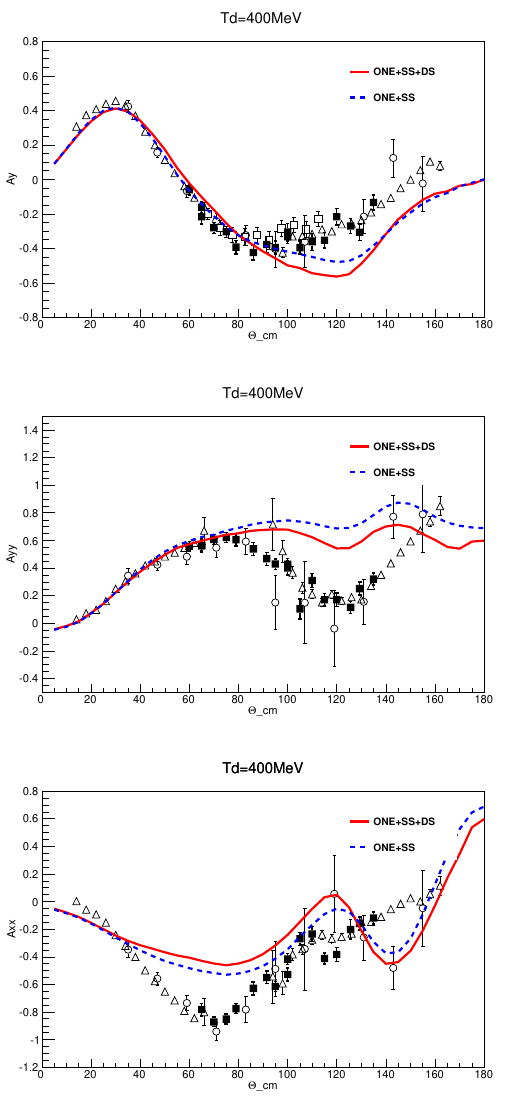
Figure 5. The angular dependence of the tensor analyzing power A xx at the deuteron kinetic energy T d of 400 MeV. Symbols and lines are the same as in Fig.